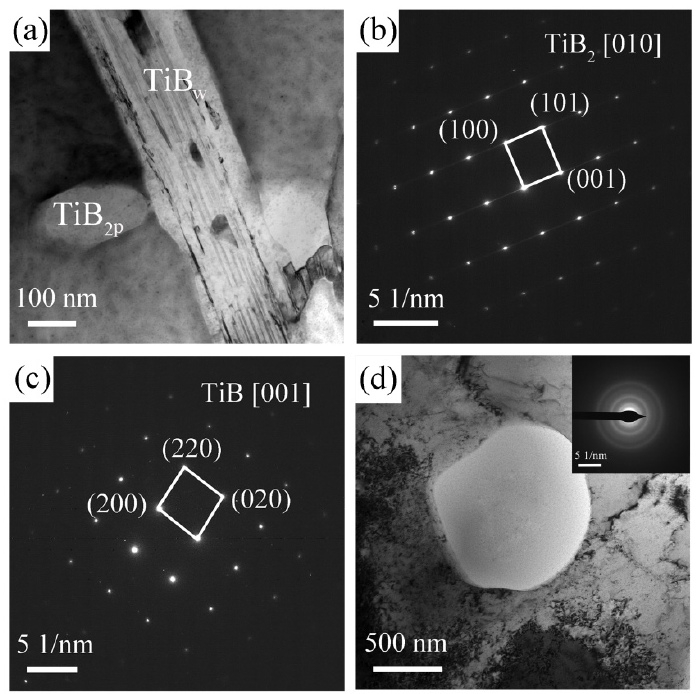
Figure 3. The TEM images of as-cast (TiB 2p +TiB w )/Cu composites prepared at 1300 °C. ( a ) Bright field of TiB 2p and TiB w , ( b ) The diffraction pattern of TiB 2p , ( c ) The diffraction pattern of TiB w , ( d ) Unreacted B exists in amorphous form.